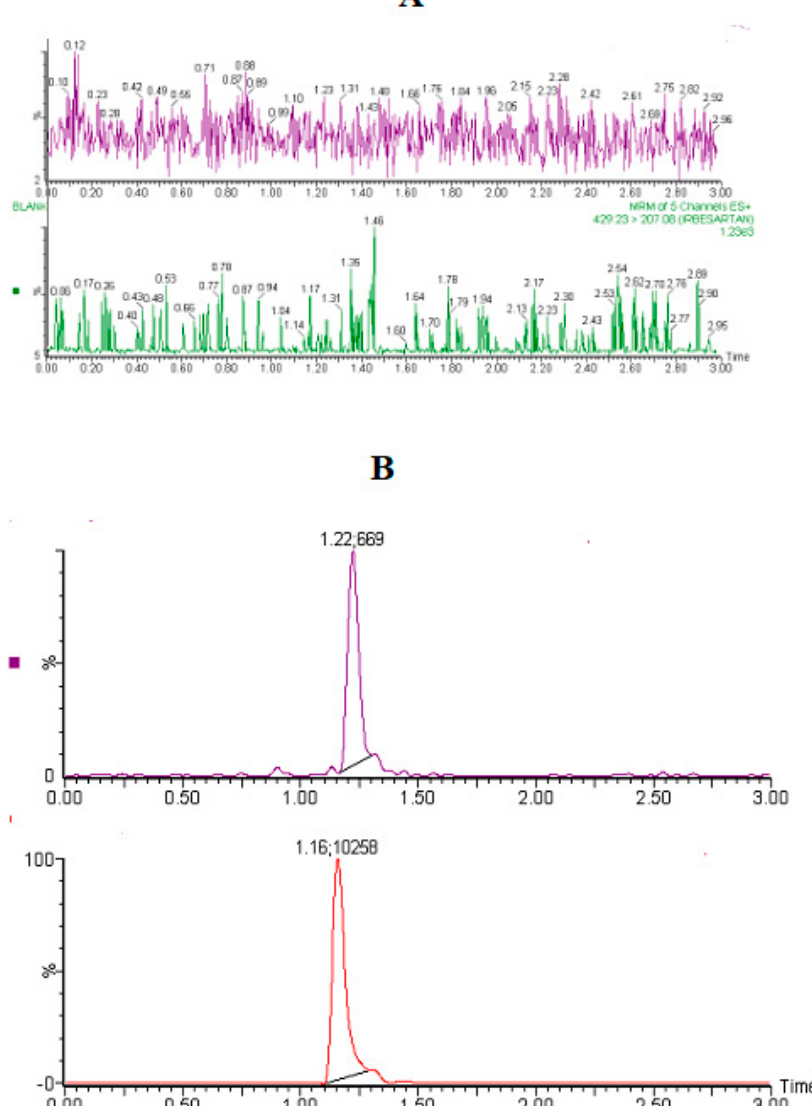
Figure 3. MRM Chromatograms of baricitinib and internal standard in blank rat plasma ( A ), and plasma spiked at LLOQ level ( B